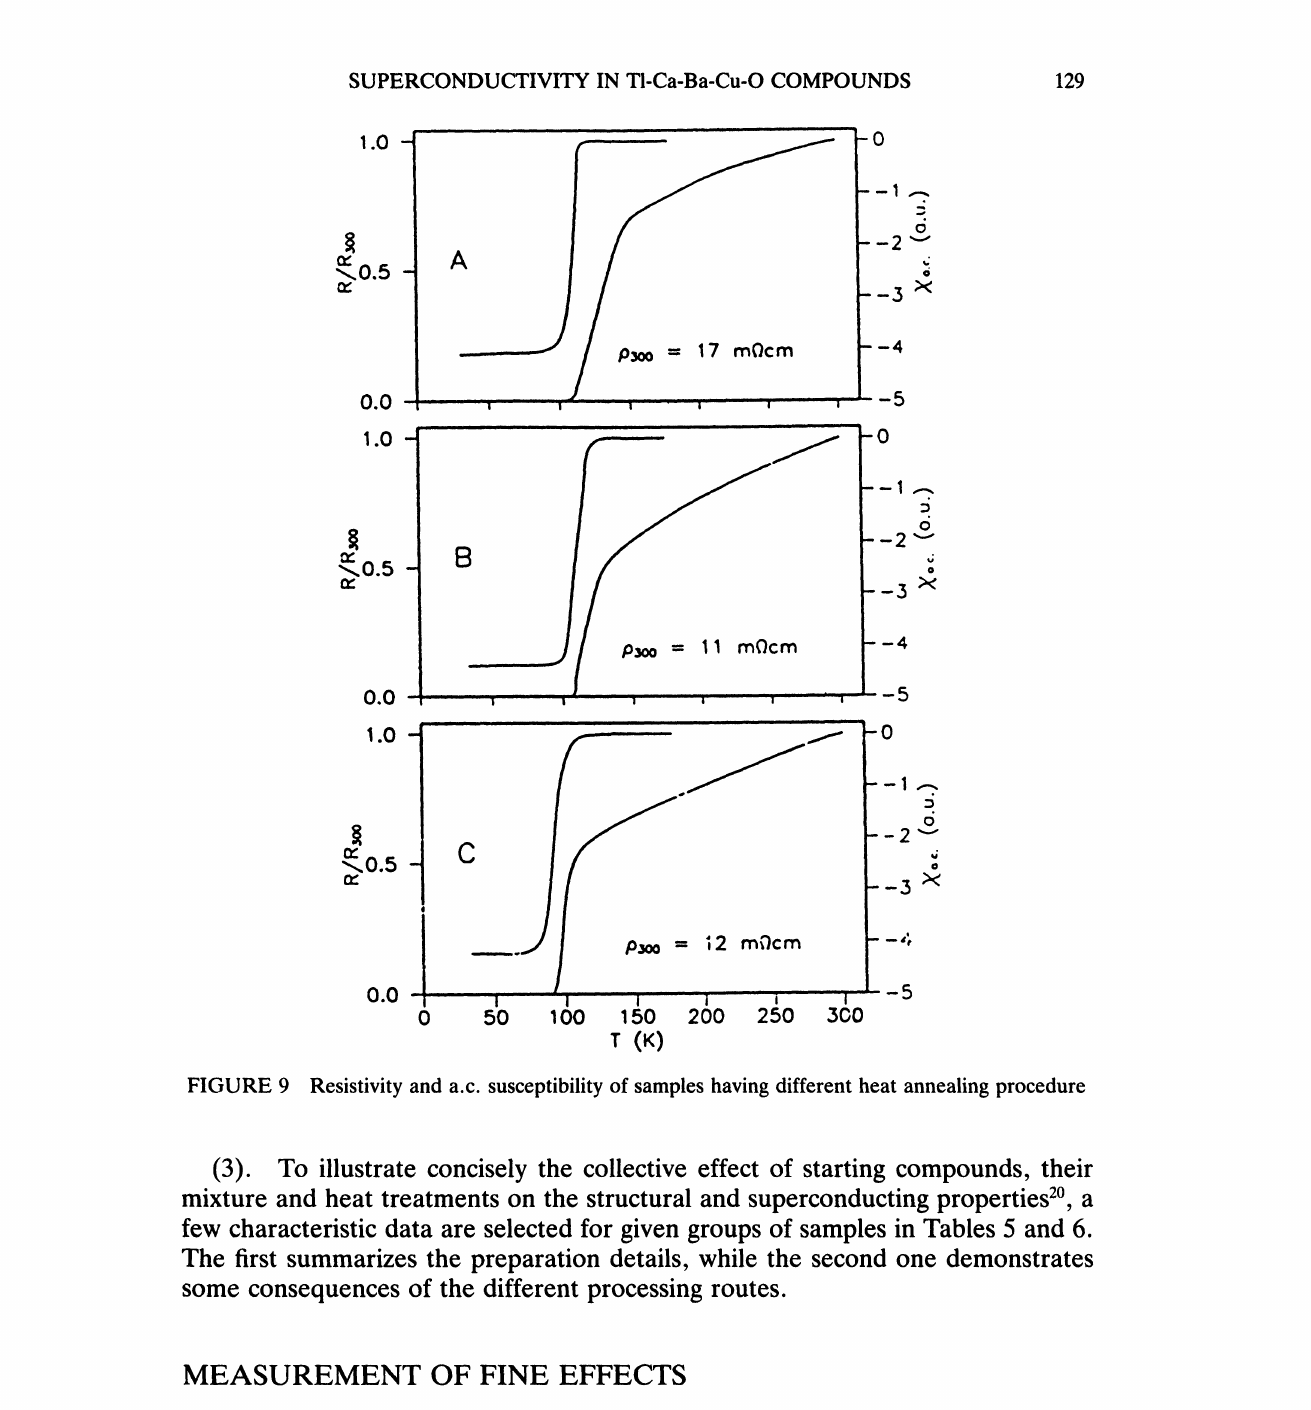
FIGURE 9 Resistivity and a.c. susceptibility of samples having different heat annealing procedure